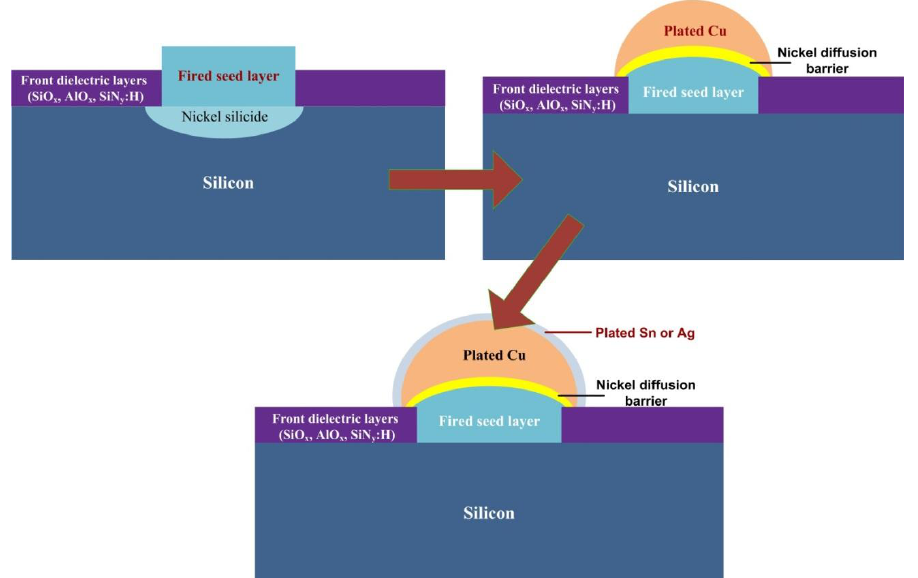
Figure 8. Schematic structures for the steps involved in the formation of metallization scheme based on Ni/Cu/Sn or Ag